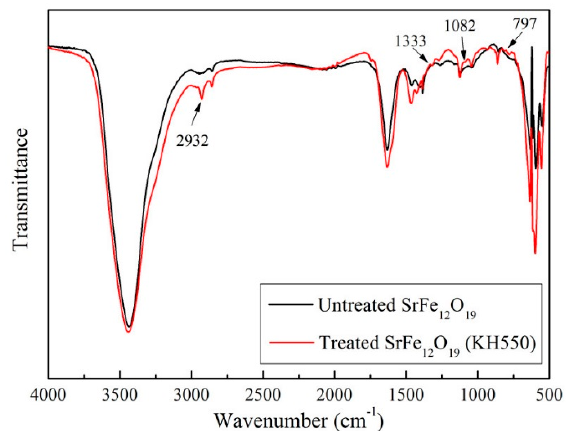
Figure 2. Infrared spectrum analysis of SrFe 12 O 19 particles before and after modification with KH550.